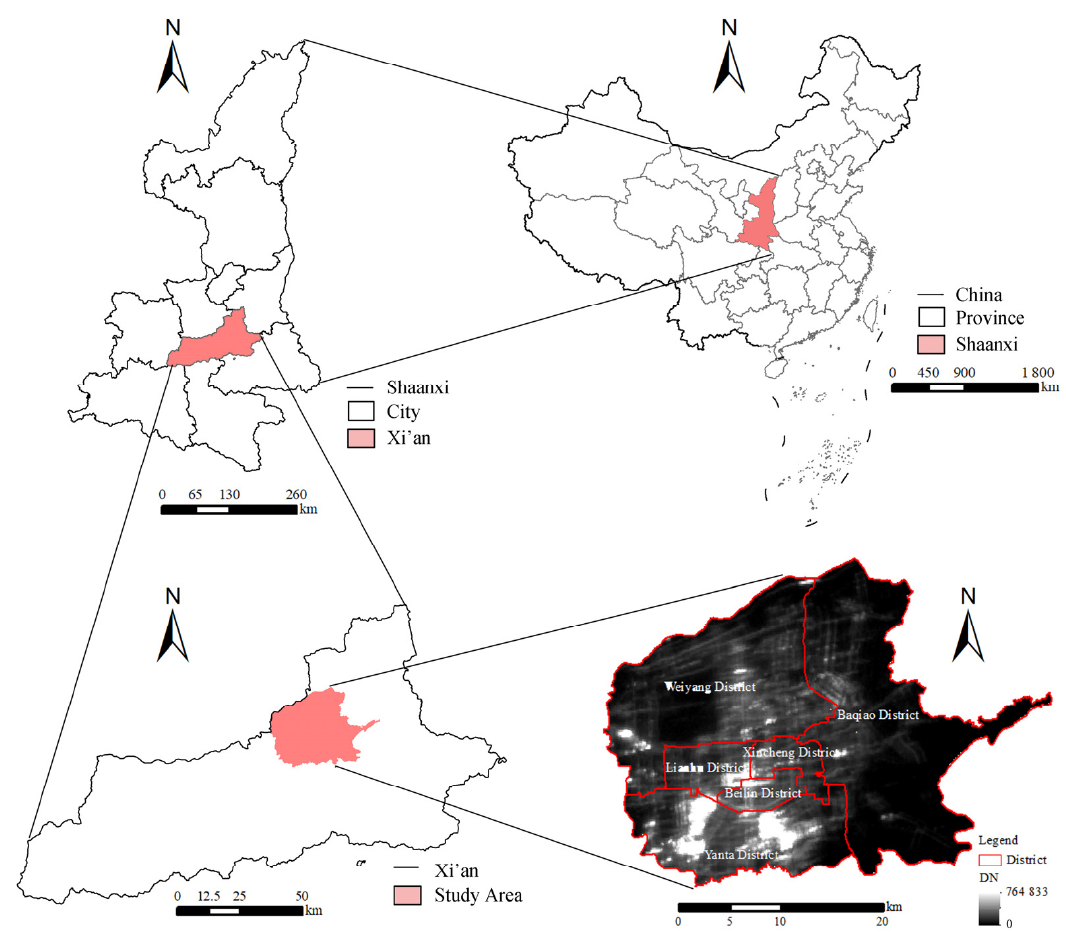
Figure 1. Location of the study area. Table 1. Comparison of different nighttime light data